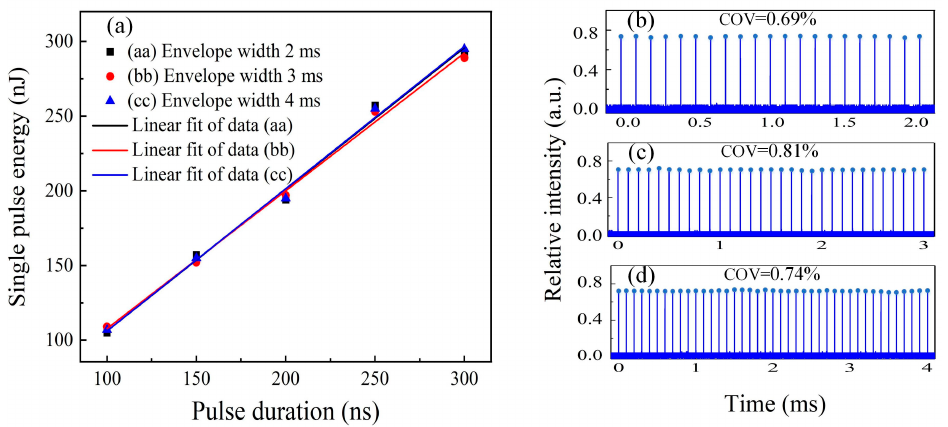
Figure 3. ( a ) Output pulse energy versus pulse duration over envelope widths of 2 ms to 4 ms at 10 kHz frequency; ( b ) 2 ms burst profile distribution; ( c ) 3 ms burst profile distribution; ( d ) 4 ms burst profile